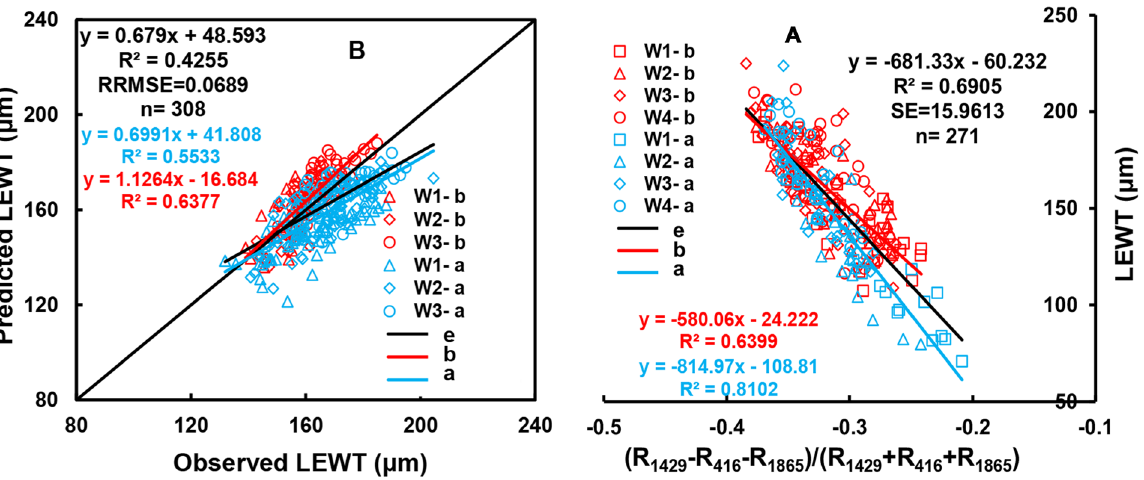
Figure 10. Quantitative relationships between (R 1429 2 R 416 2 R 1865 )/(R 1429 + R 416 + R 1865 ) between LEWT in wheat (A); the 1:1 relationship between the predicted and observed LEWT on (R 1429 2 R 416 2 R 1865 )/(R 1429 + R 416 + R 1865 )